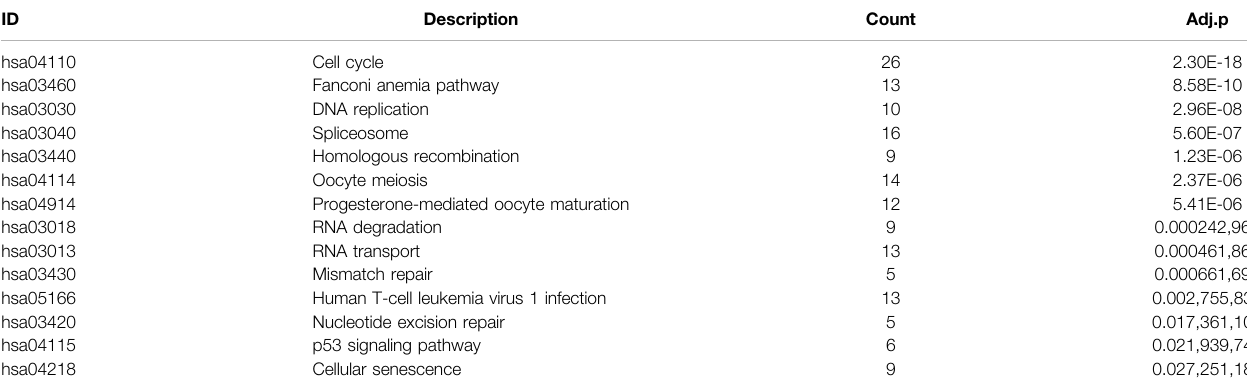
TABLE 3 | Genes co-expressed with SPDL1 involved in signaling pathways based on KEGG analysis.